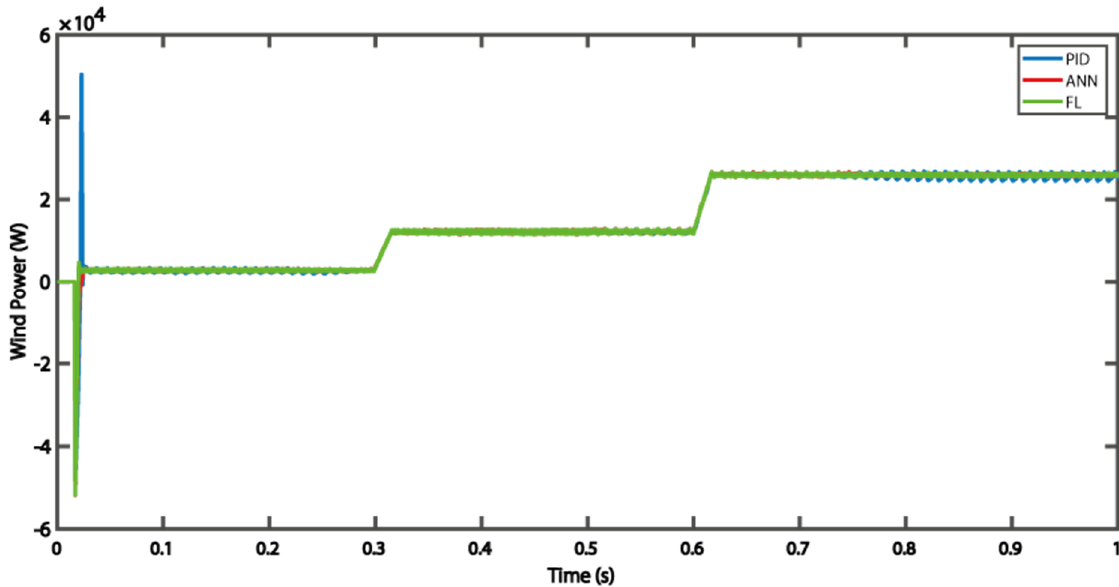
Figure 17. The power produced from wind turbines (W). At the beginning of the simulation between t = 0 s and t = 0.3 s, the sum of the